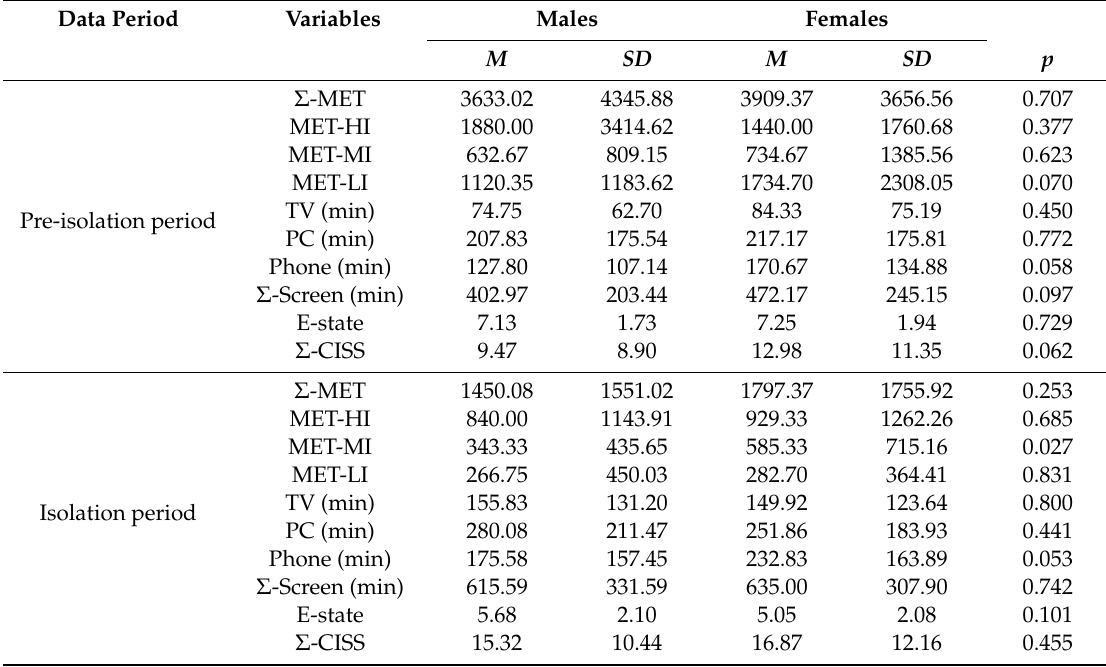
Table 2. Di ff erences by gender and by isolation period.